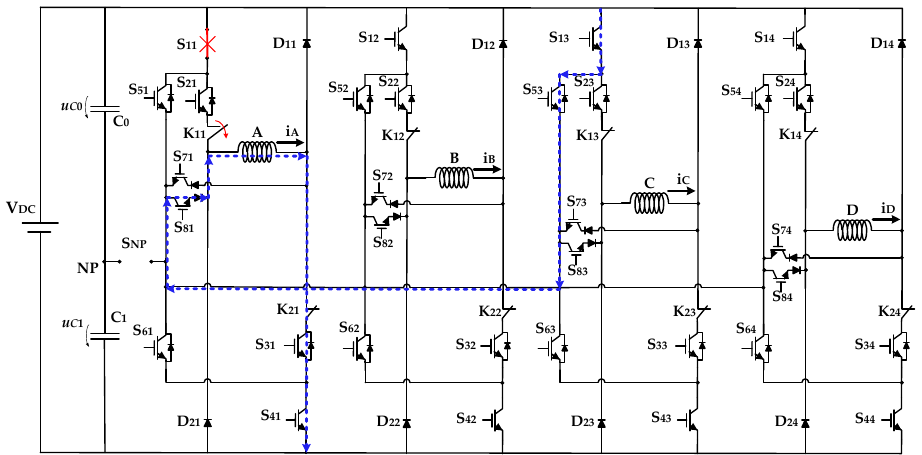
Figure 6. Fault-tolerant solution based on the NPC-AHB topology applied to an 8/6 SRM . Example of a short-circuit fault in power device S 11 and recover path to obtain the full voltage of phase A . A single path is available after isolation using the mechanical relay K 11 .